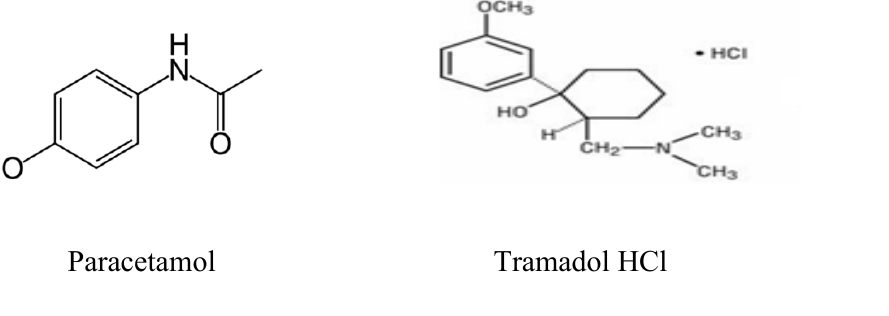
Figure 1. Structure of paracetamol and